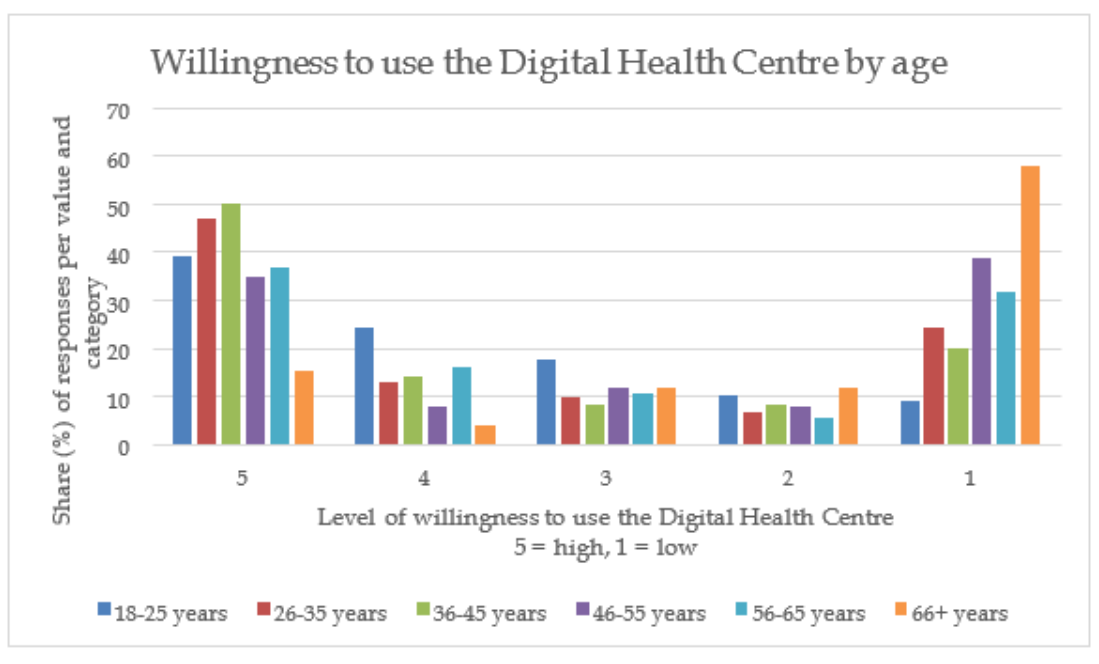
Figure 11. Willingness to use the Digital Health Centre and age. Percentage per reported value on scale. 18- 25 years n=79 (100%), 26-35 years n=62 (100%), 36-45 years n=50 (100%), 46-55 years n=26 (100%), 56- 65 years n=19 (100%), 66+ years n=25 (100%). Total n=263.